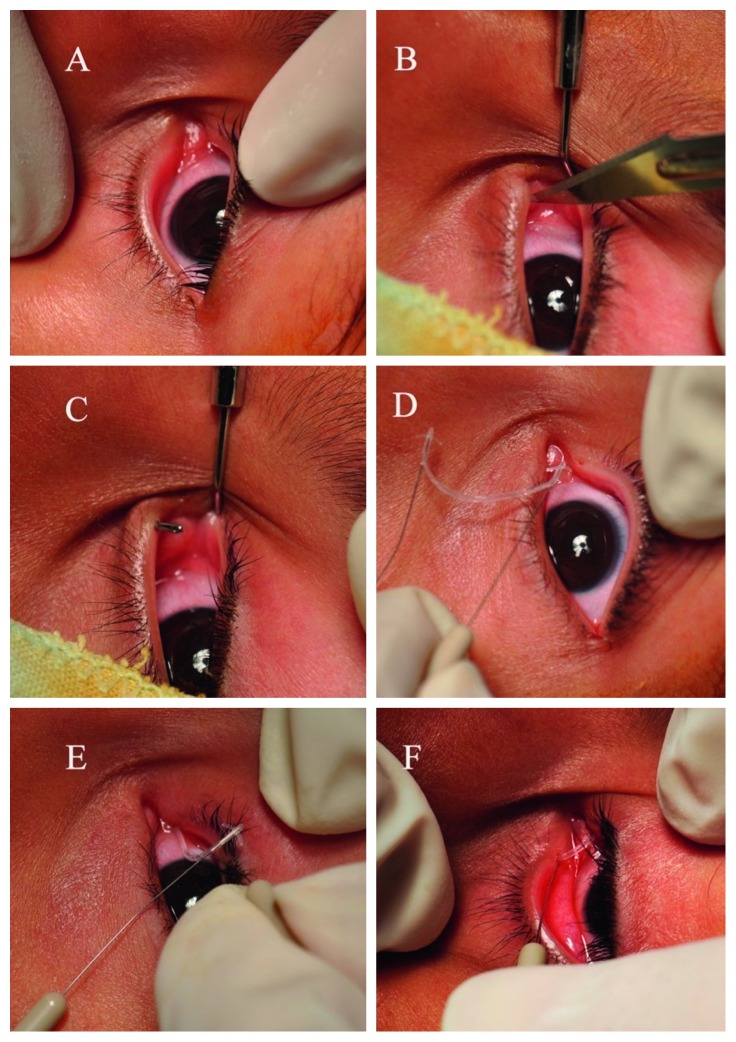
(a) Appearance of grade 0 lower punctal stenosis. (b) Using the pigtail probe to detect the stenosed lower punctum. (c) Opening of the lower punctum. (d) Inserting the self-retaining bicanalicular stent through the patent upper punctum and canaliculus. (e) Inserting the self-retaining bicanalicular stent through the patent lower punctum and canaliculus. (f) The final appearance after insertion of the stent.